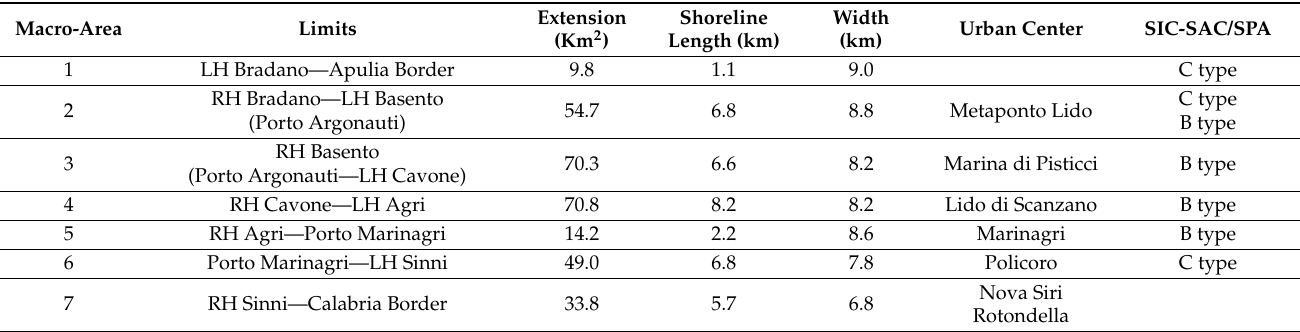
Table 7. Main characteristics of the